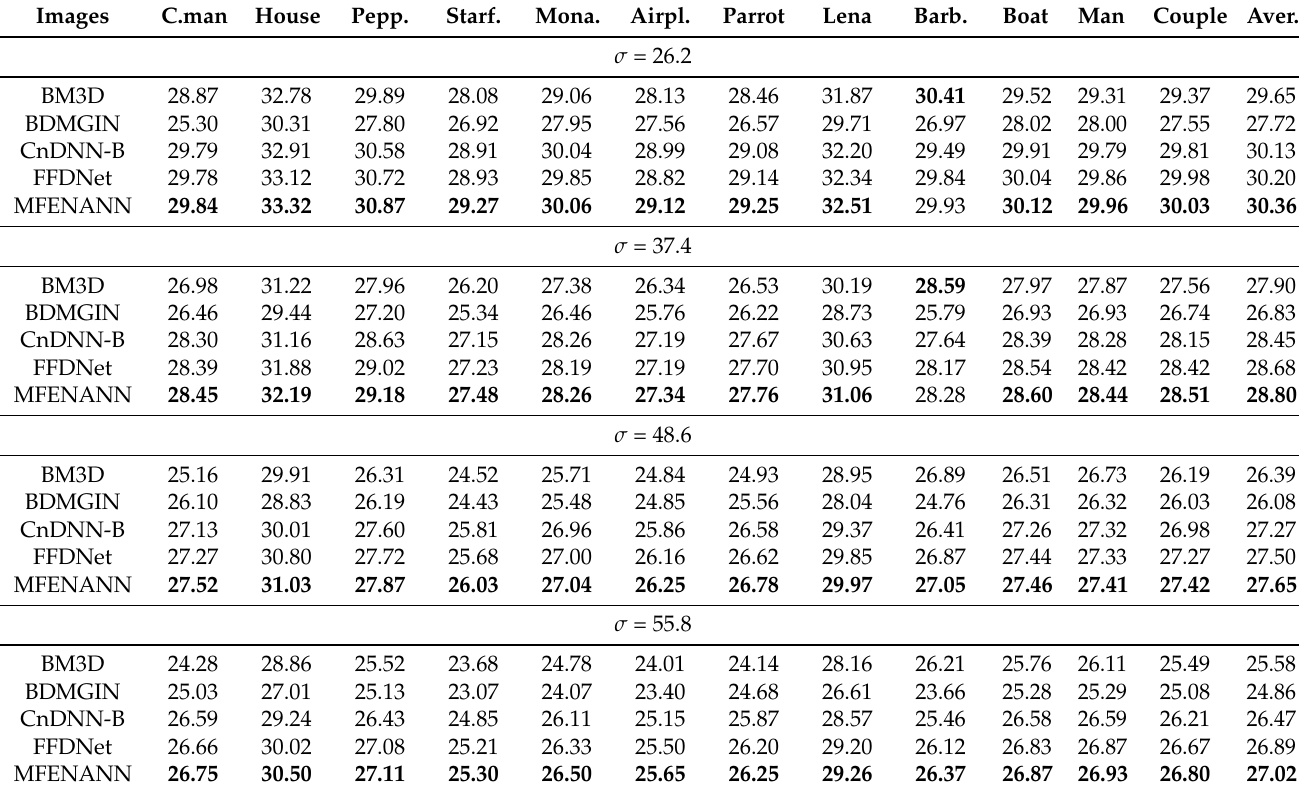
Table 7. The PSNR (dB) values for restored images from “Set12” using several methods with unknown noise levels. The bold numbers are the largest from the corresponding noise levels. Images